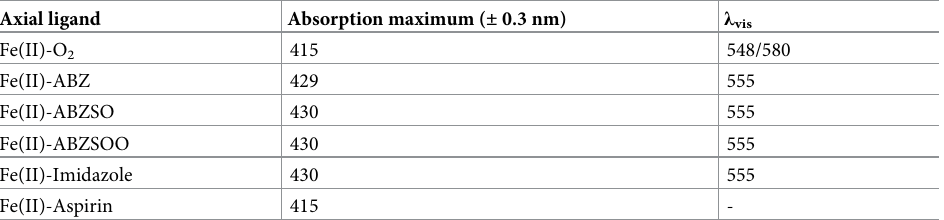
Table 2. Spectroscopic properties of NADH-reduced gFlHb under aerobic conditions in the presence of albenda- zole and other ligands. Axial